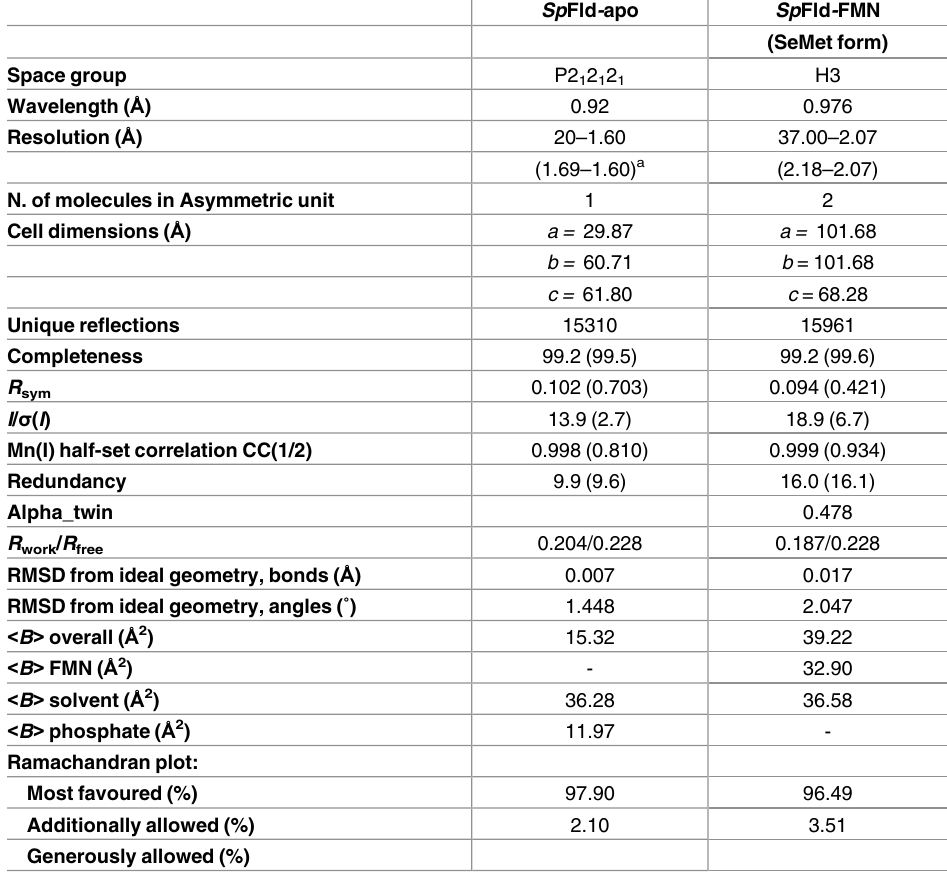
Table 3. Data collection and refinement statistics of holo and apo Sp Fld crystallographic